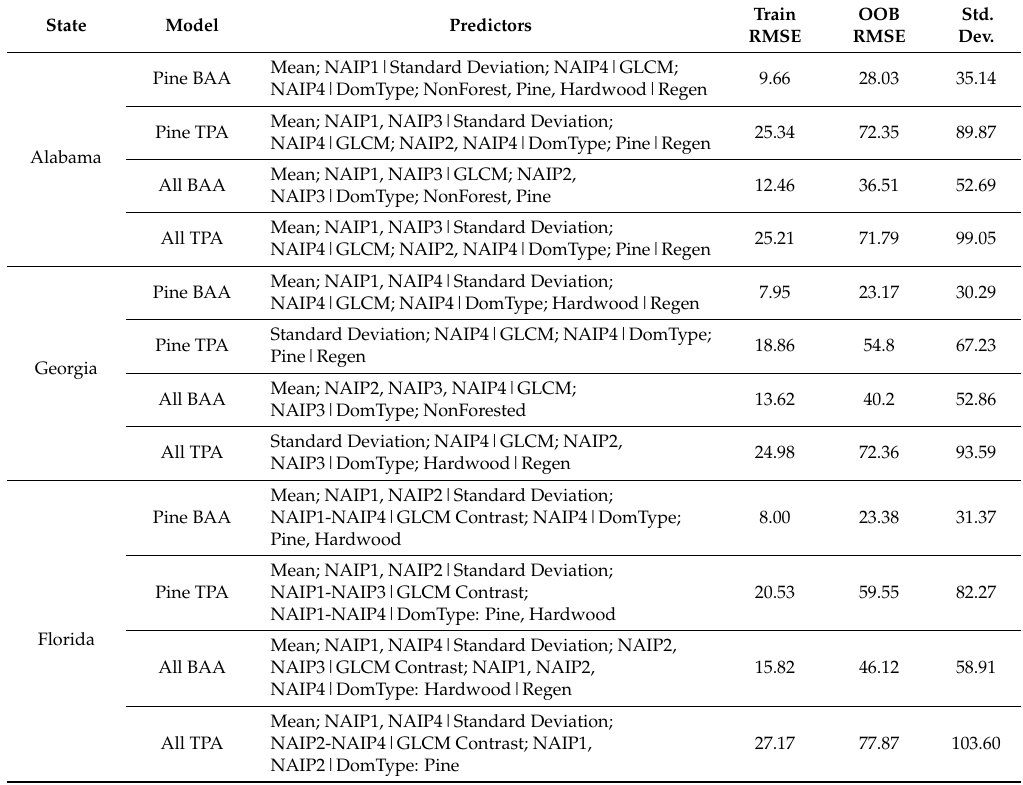
Table 4. Random Forest model predictor variables used, fit statistics for BAA and TPA, and standard deviation of FIA plots.